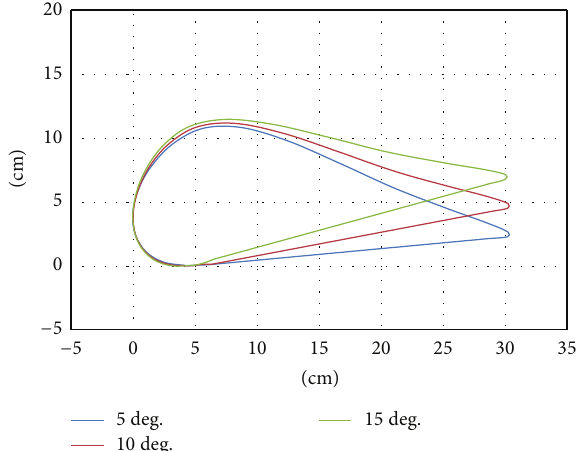
Figure 6: Trajectory of the footpad in acclivity walking.